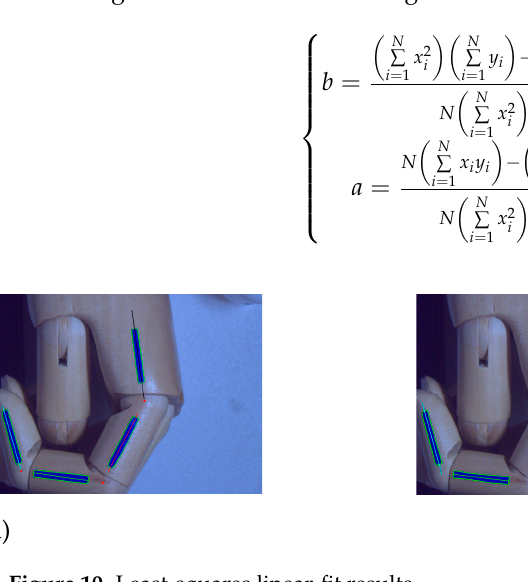
Figure 10. Least-squares linear-fit results.